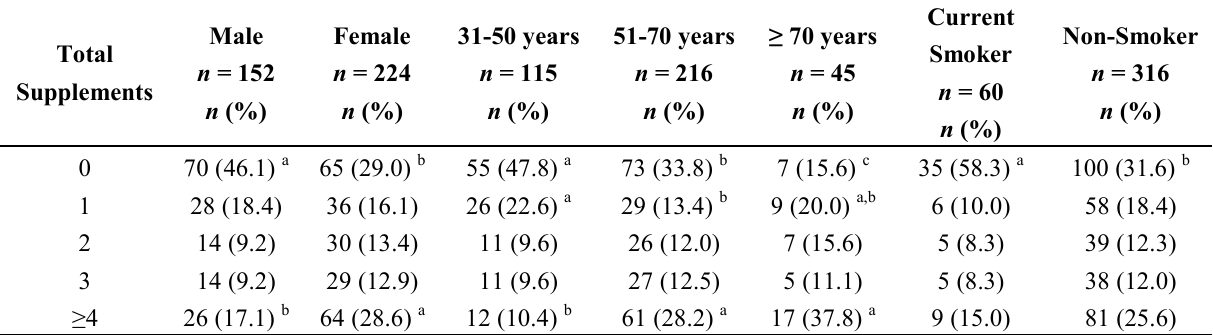
Table 2. Total Supplements Used by Sex, Age and Smoking Status.